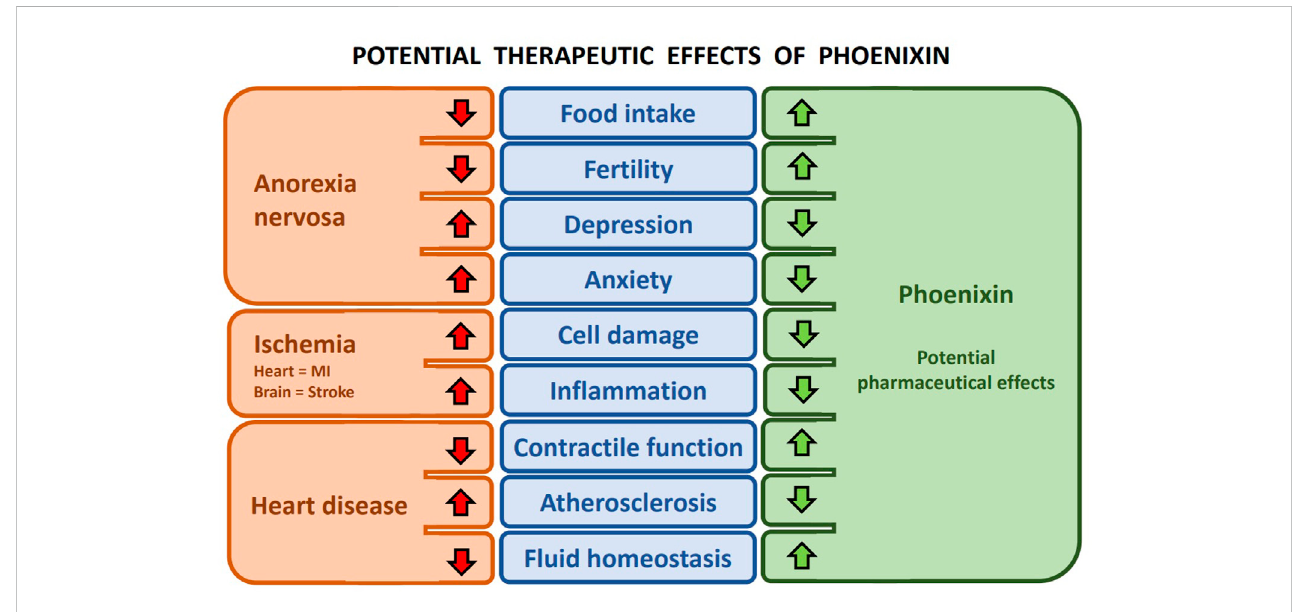
FIGURE 1 Potential therapeutic effects of phoenixin – The effects of pathologies (red arrows) on physiological functions (blue) and the associated possible therapeutic effects of phoenixin (green arrows) on those affected